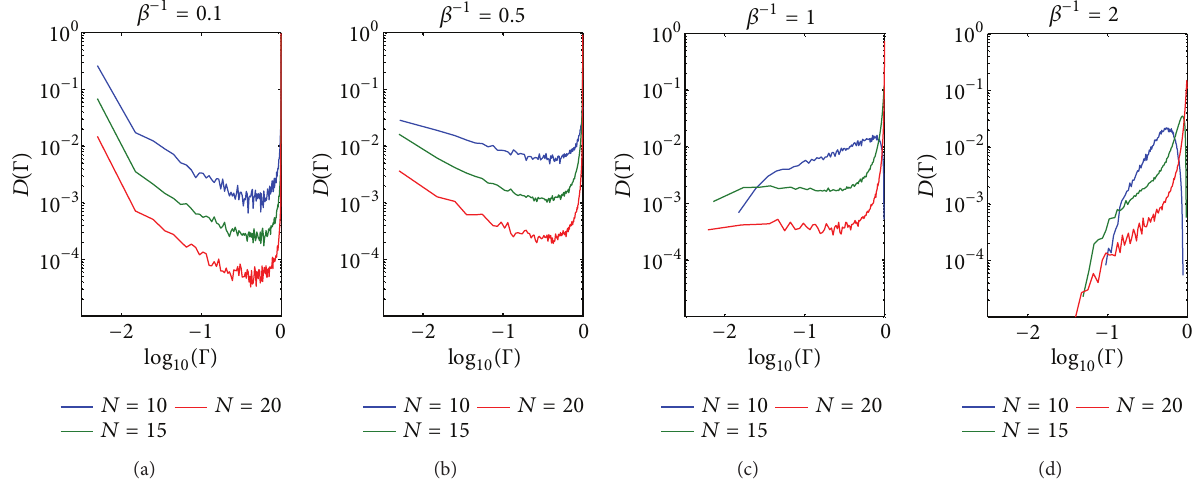
Figure6:Distributionof Γ , 𝐷(Γ) ,forvarious 𝑁 foranIsing-GlauberspinlatticewithferromagneticRKKYinteractions.Differenttemperature dependent 𝐷(Γ) is shown for (a) 𝛽 −1 = 0.2 , (b) 𝛽 −1 = 0.5 , (c) 𝛽 −1 = 1 , and (d) 𝛽 −1 = 5 . 𝐷(Γ) is normalized over 2 𝑁 column entries and then averaged over 256 equally spaced